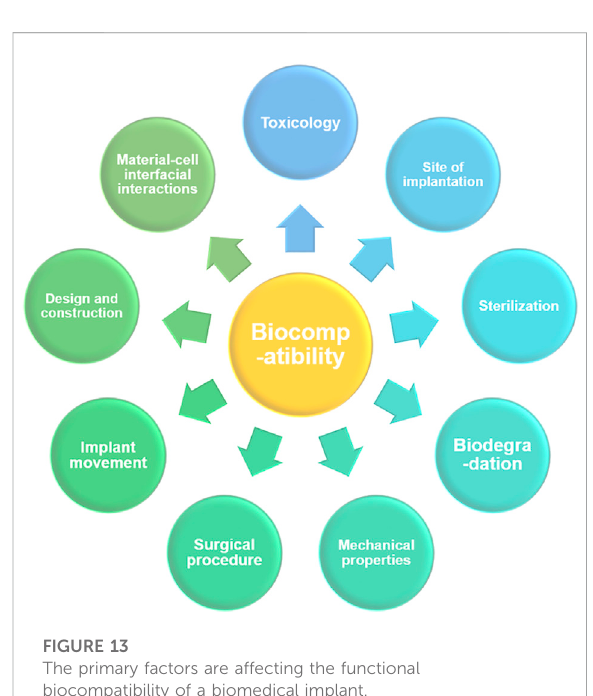
FIGURE 13 The primary factors are affecting the functional biocompatibility of a biomedical